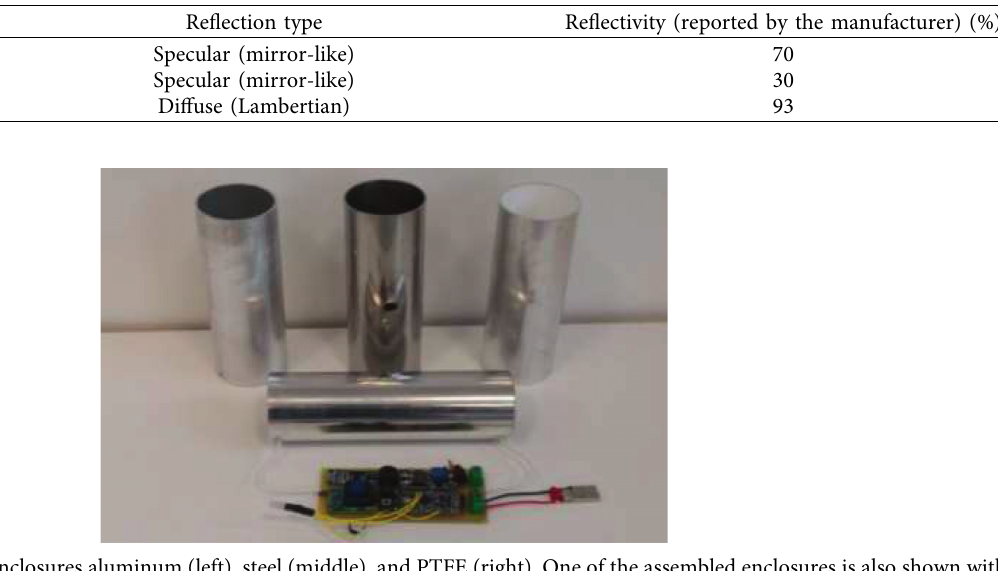
Table 4: Enclosure materials and their reflectivity.